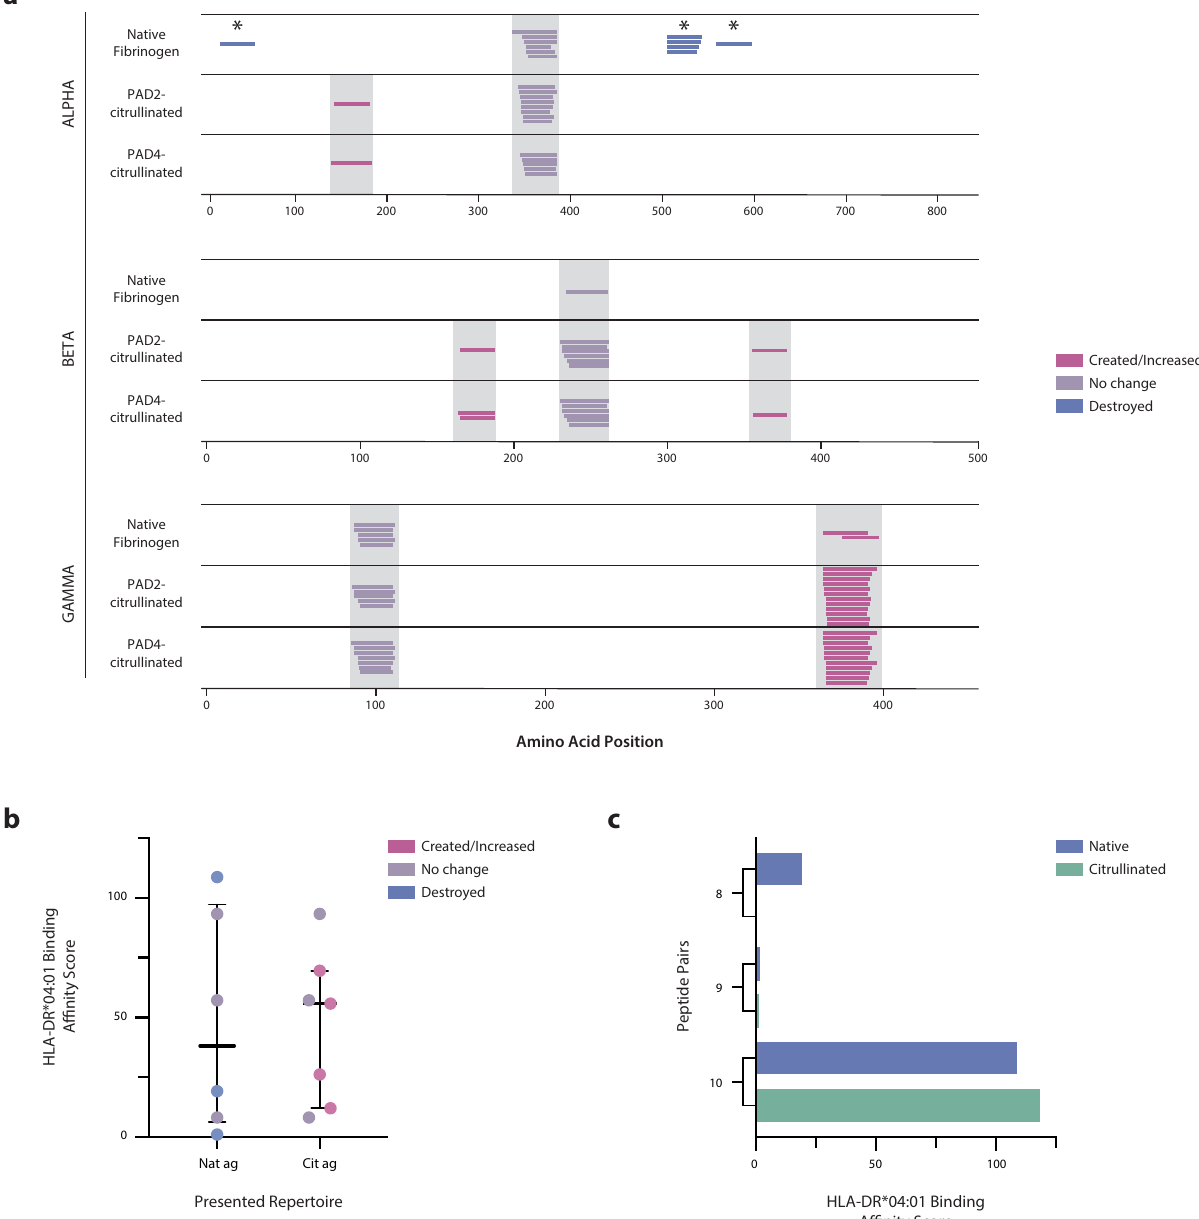
Fig. 5 | Citrullination alters the naturally presented peptide repertoire pre- sented by human mo-DCs. a NAPA performed on mo-DCs from a SE + healthy donorpulsedwithnativeandcitrullinated fi brinogen.Peptidesfromthe α , β ,and γ chains of fi brinogen are shown. Each colored line represents a unique peptide coded according to the legend, and gray bars denote peptides with identical core motifs between samples. *Denotes a citrullination site. b HLA-DRB1*04:01 relative binding af fi nity scores for the presented peptide repertoires derived from the